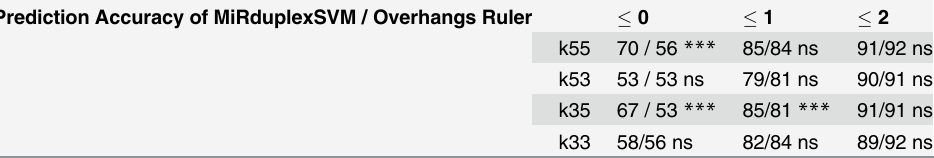
Missing duplexes prediction results for MiRduplexSVM and the Overhangs Ruler. MiRduplexSVM outperforms Overhangs ruler in the identi fi cation of the start position of the mature miRNA that lie on the 5 0 or the 3 0 strand, but achieves the same accuracy on the prediction of their end positions. Statistical signi fi cance was assessed using the Fisher exact